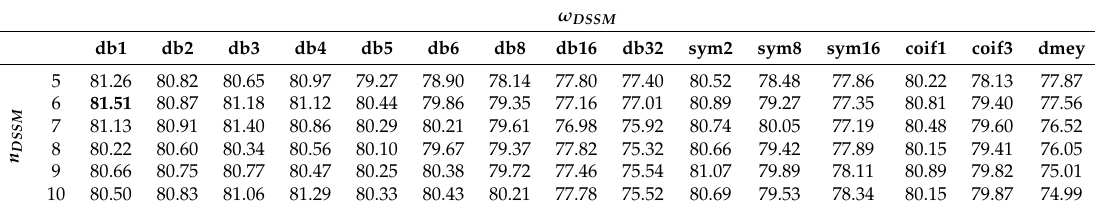
Table 13. The accuracy (%) of four class sleep stage classification with different wavelet bases and different order of DSSM under AASM standard. Only DSSMFs are used, no LEFs.